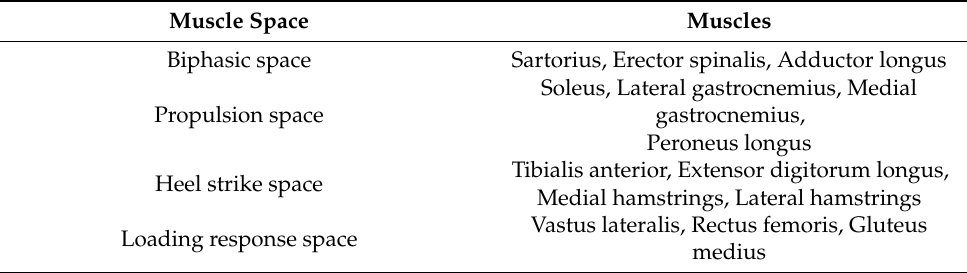
Table 1. Gait space of muscles of the lower extremities.